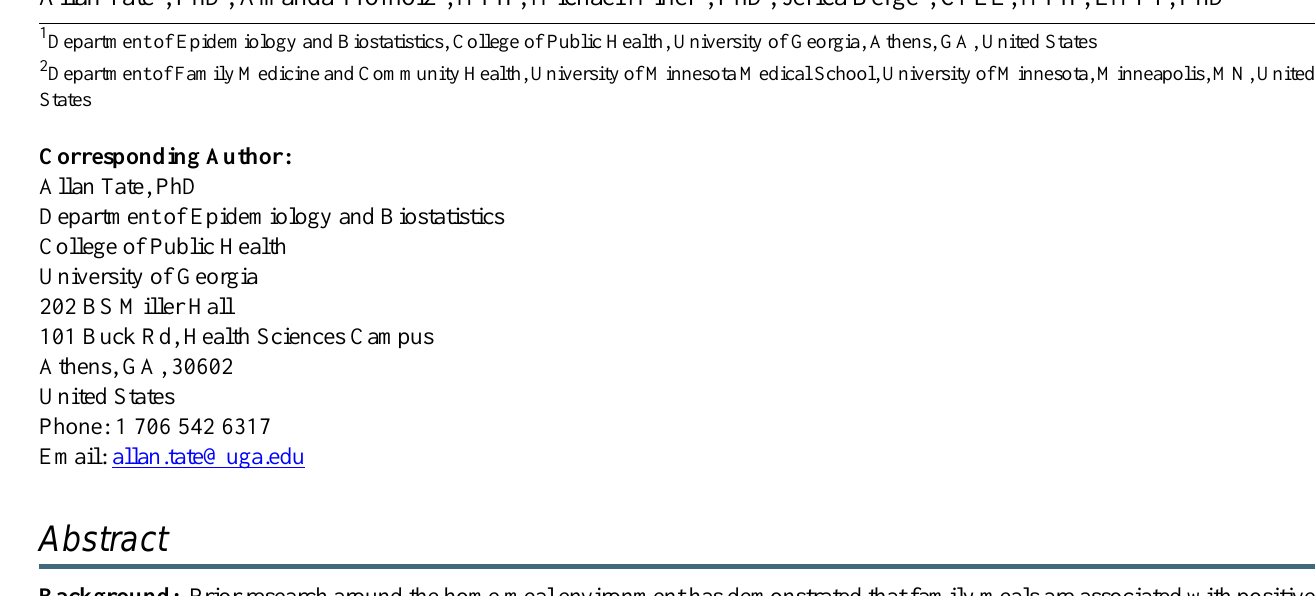
meal healthfulness; direct observation; family meals; well-being; diet;